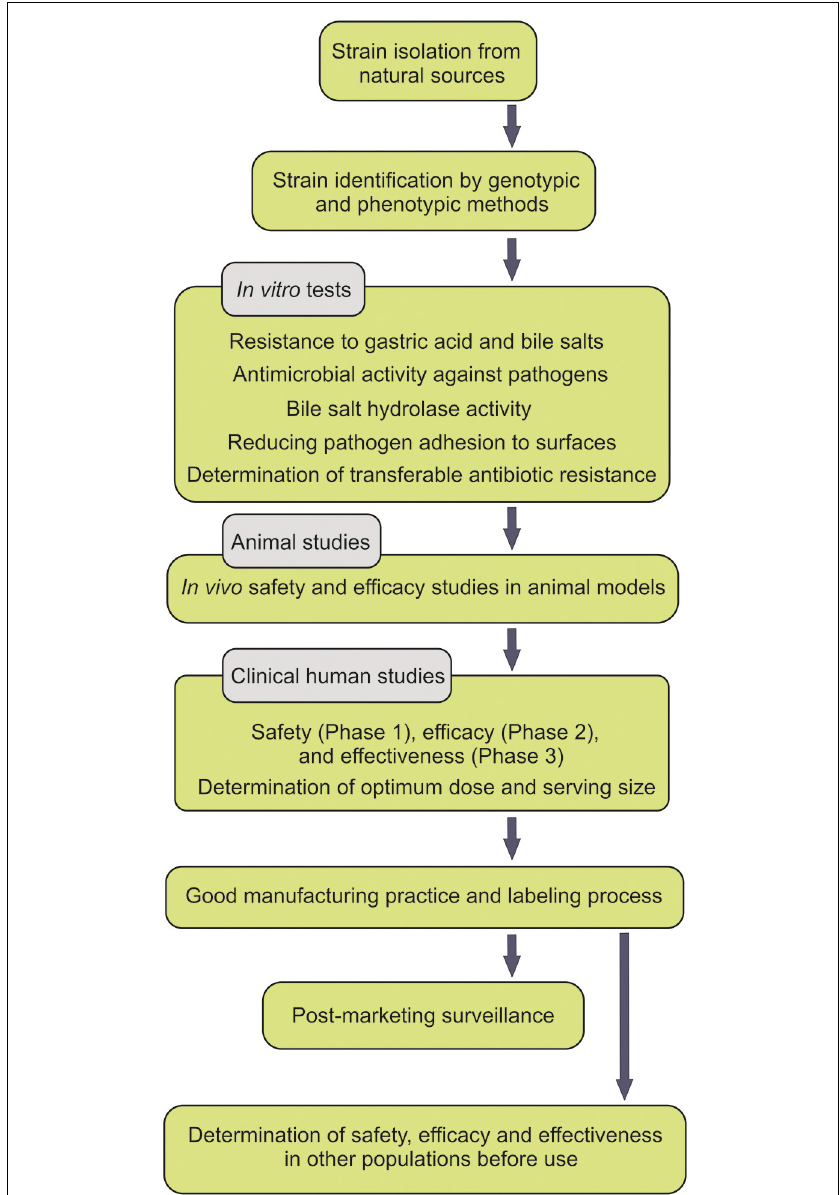
FIGURE 1 | WHO Guideline for isolation and application of